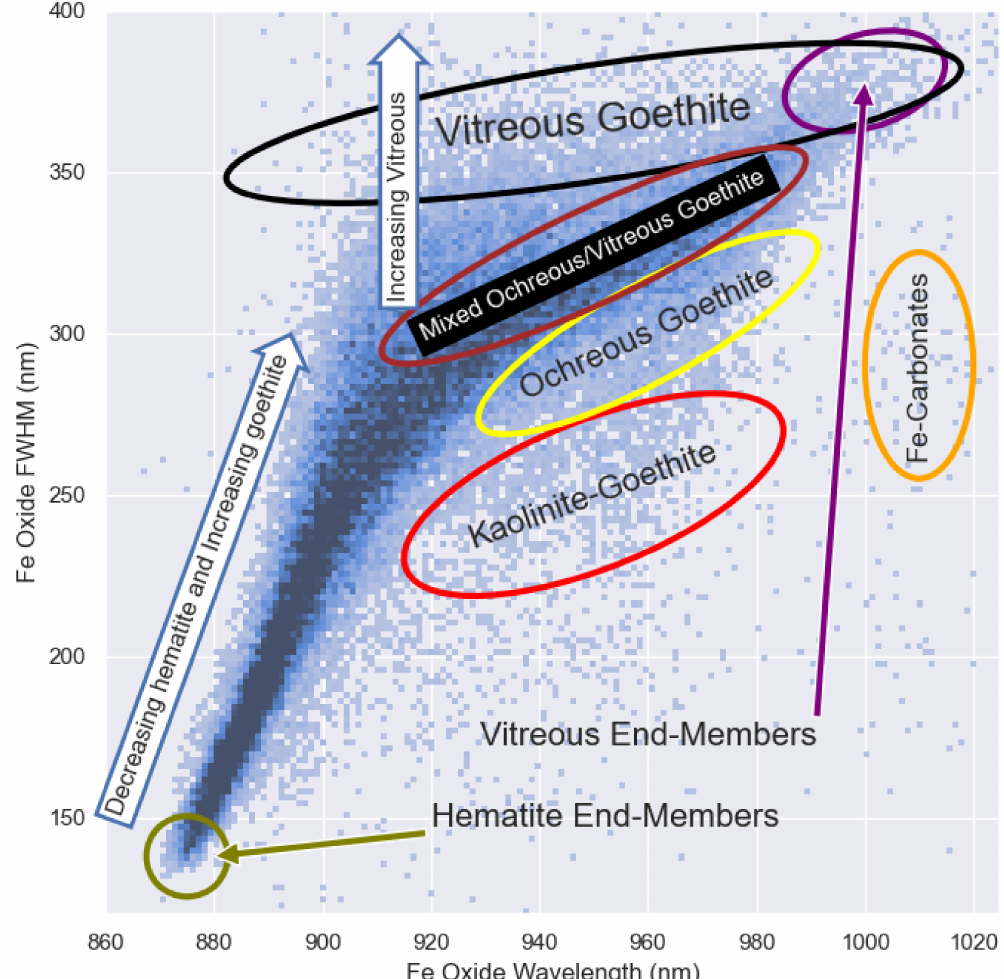
Figure 3. The density plot of the complete dataset with no SWIR masking is shown and outlines the general composition and placement of key locations within the iron boomerang. At each end are two spectral endmembers comprised of hematite around a Fe oxide wavelength of 870 nm and Fe oxide FWHM of approximately 140 nm and vitreous goethite located approximately at a Fe oxide wavelength of >980 nm and Fe oxide FWHM of >370 nm. As the iron boomerang is traversed from left to right and bottom to top the proportion of hematite to goethite decreases toward a more goethite-dominated region at wavelengths greater than approximately 920 nm. As the Fe oxide FWHM increases within the goethite-dominated region, a move from more ochreous goethite to greater proportions of vitreous goethite is observed. At Fe oxide FWHM values greater than 370 nm, the samples are found to be primarily vitreous goethite, while the bottom edge of the goethite region (yellow ellipse) tends to be dominated by ochreous goethite in the absence of kaolinite. The densest portion of the goethite region within the iron boomerang is comprised of mixed ochreous and vitreous goethite (brown ellipse) and may be more representative of brown